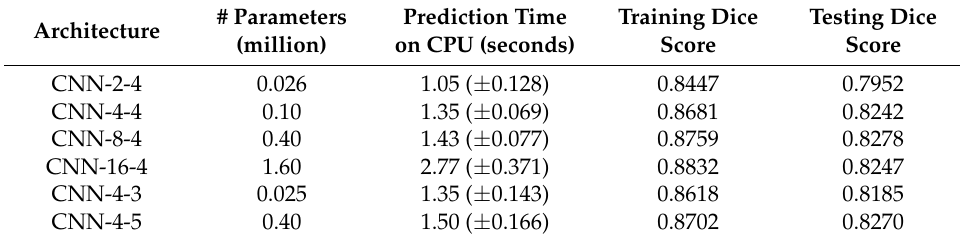
Table 3. Comparison of different sized